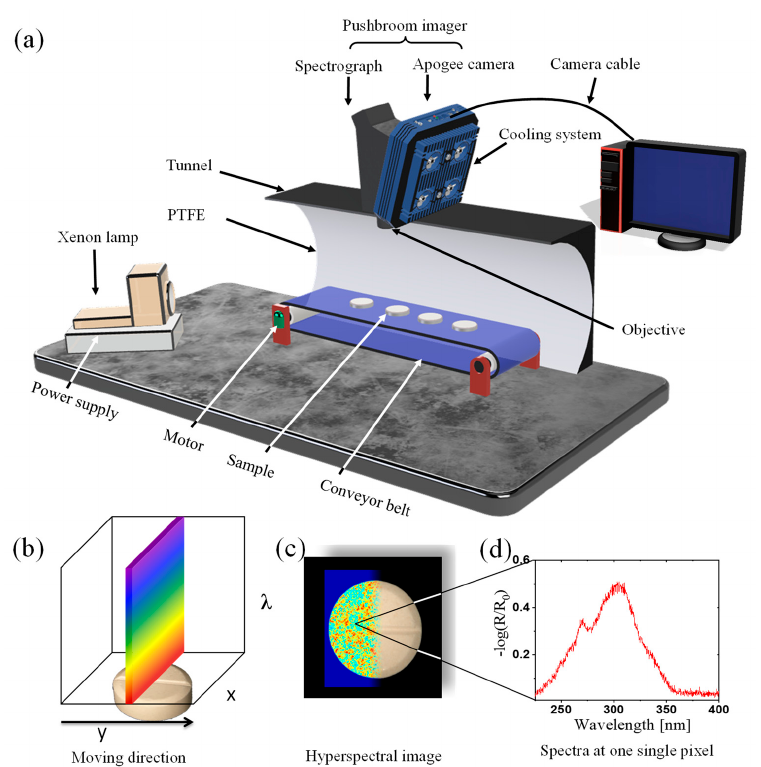
Figure 2. ( a ) Setup of a hyperspectral imaging system based on the pushbroom concept (the tunnel in the scheme was cut to show the inside). ( b ) Pushbroom Imager scanning principle. ( c ) Hyperspectral image generated immediately from the scanning of a sample. ( d ) UV spectrum for one single pixel extracted from the image given in ( c ).